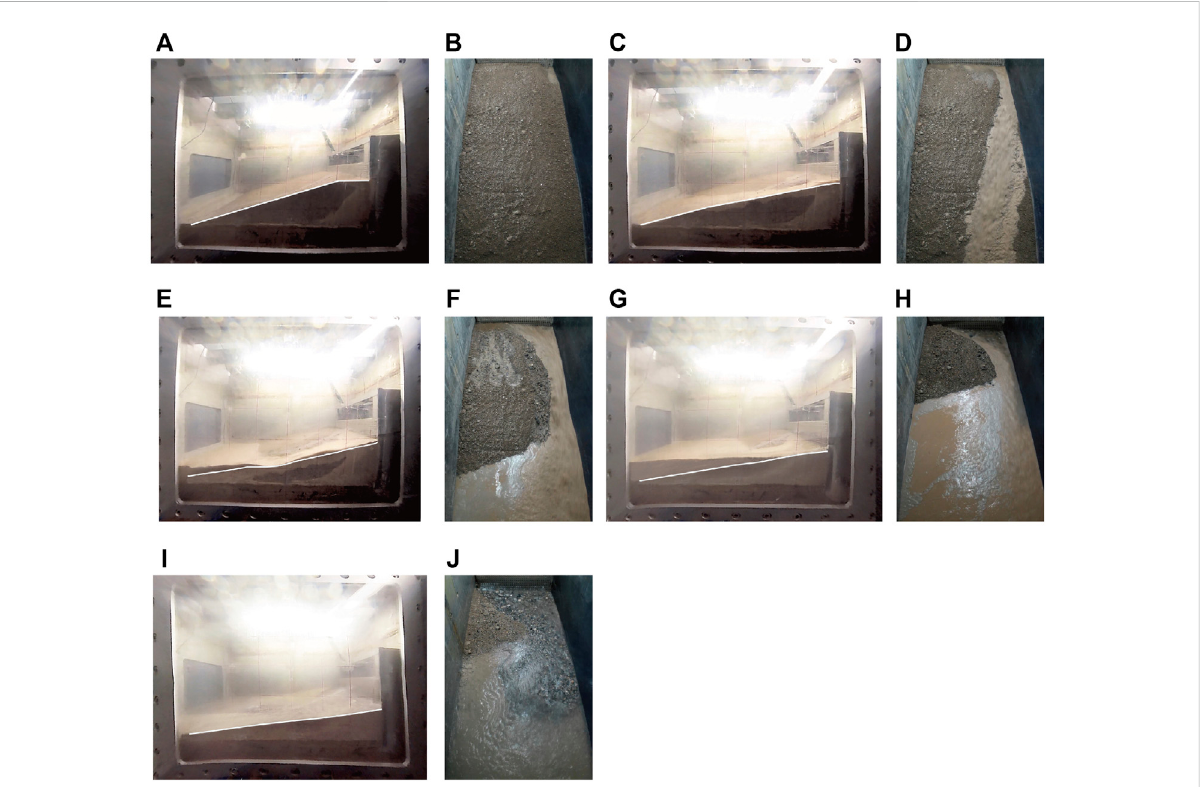
FIGURE 7 TypicaldamimagesofbreachprocessofCondition4. (A) Theinitialmomentofdamfailure(CameraNo.1). (B) Theinitialmomentofdamfailure (CameraNo.2). (C) Stage1(CameraNo.1). (D) Stage1(CameraNo.2). (E) Stage 2(Camera No.1). (F) Stage2(CameraNo.2). (G) Stage3(CameraNo. 1). (H) Stage 3 (Camera No. 2). (I) Stage 4 (Camera No. 1). (J) Stage 4 (Camera No.